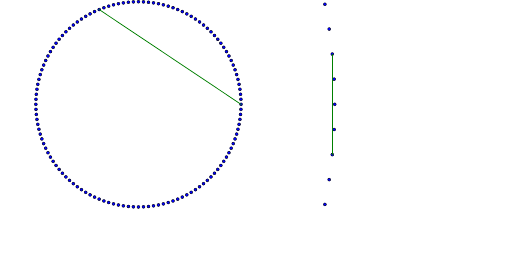
Figure 1: An illustration of the IR (left) and UV (right) covariances in a circle